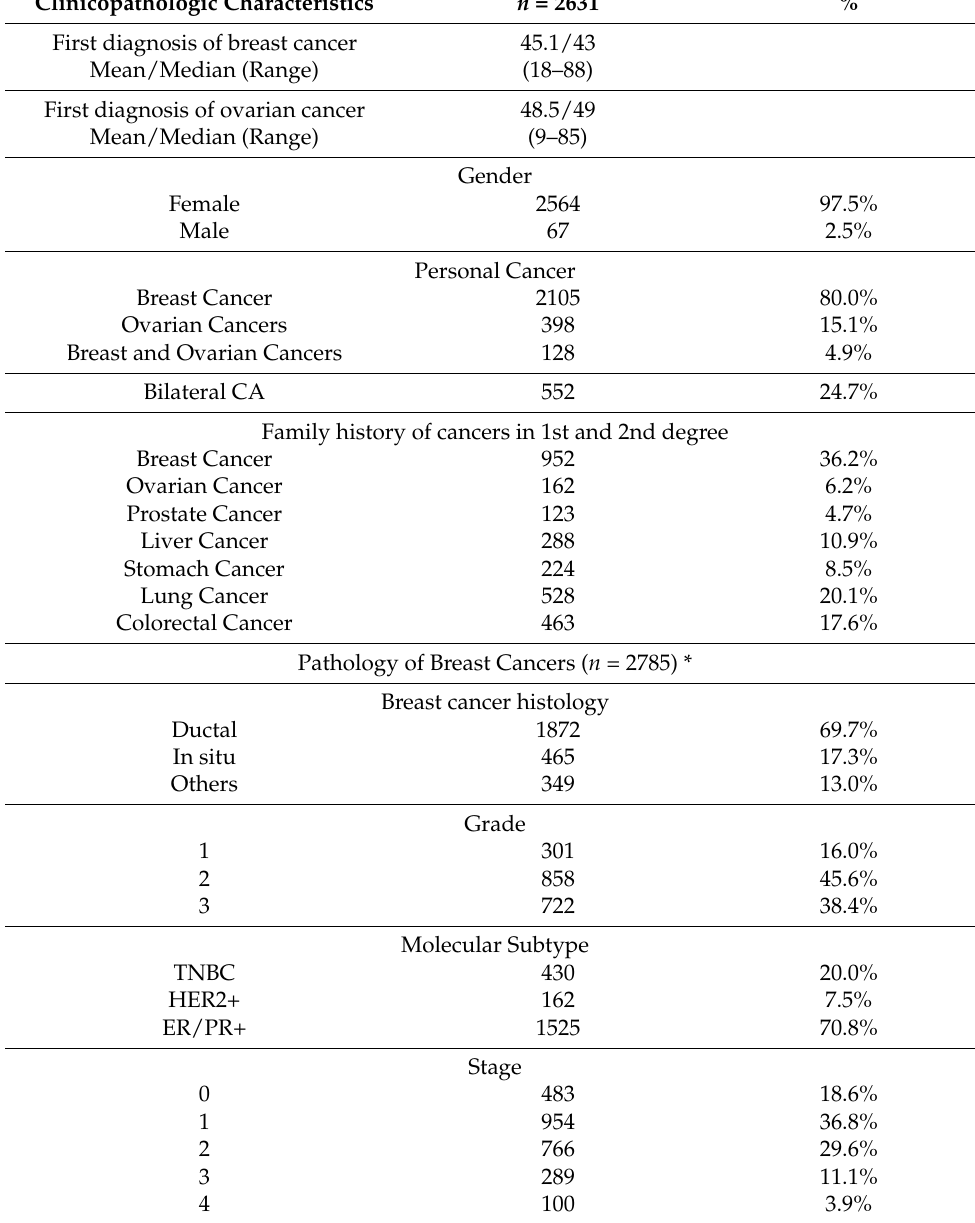
Table 1. Clinicopathologic characteristics of study